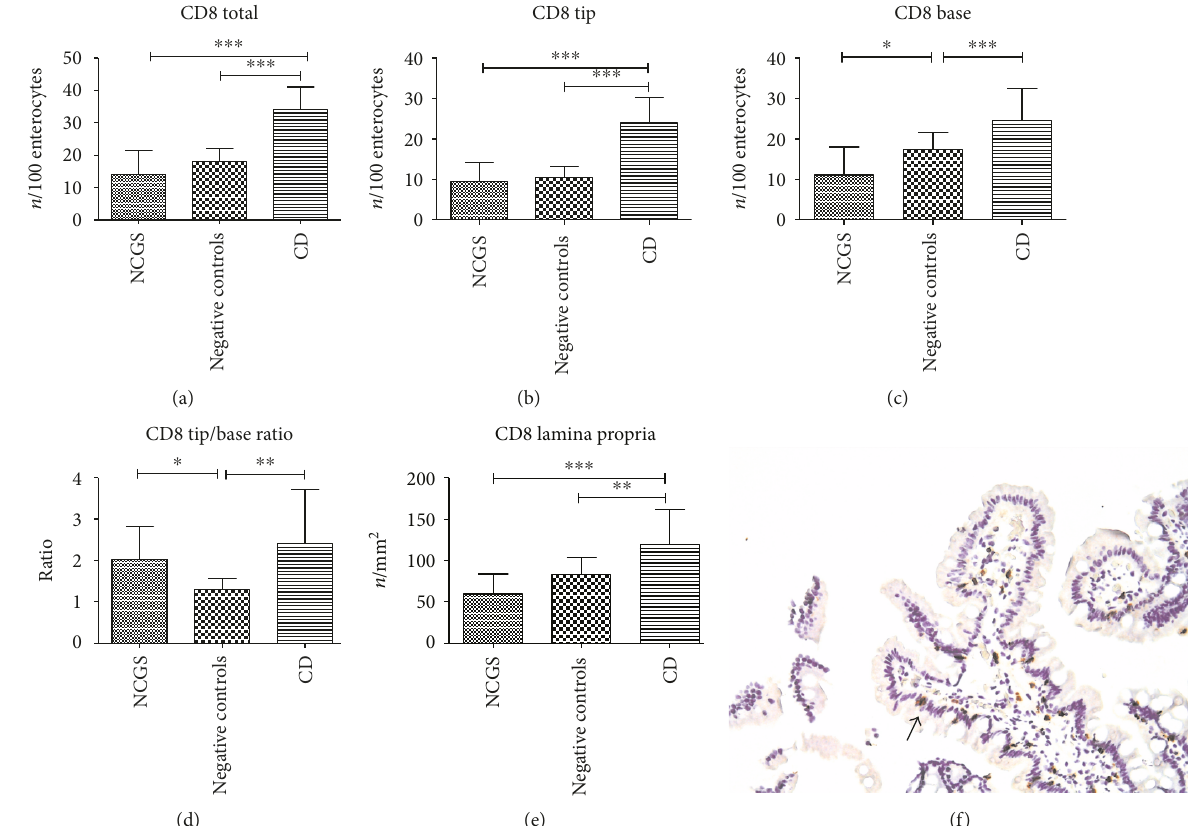
Figure 3: Immunohistochemical expression of CD8 in duodenal mucosa, both epithelial and lamina propria (a – e). Bars and error bars represent mean and standard deviation, respectively. ∗ p < 0 05 , ∗∗ p < 0 01 , and ∗∗∗ p < 0 001 . (f) An immunohistochemical picture of a patient with NCGS: positive cells are stained in brown, magni fi cation × 200. An arrow highlights positive